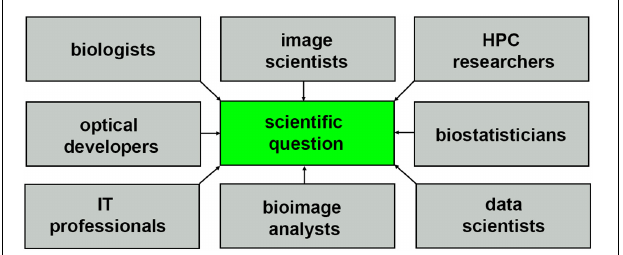
FIGURE 7 | Community of researchers that help to turn light-sheet image data into scientific insight.